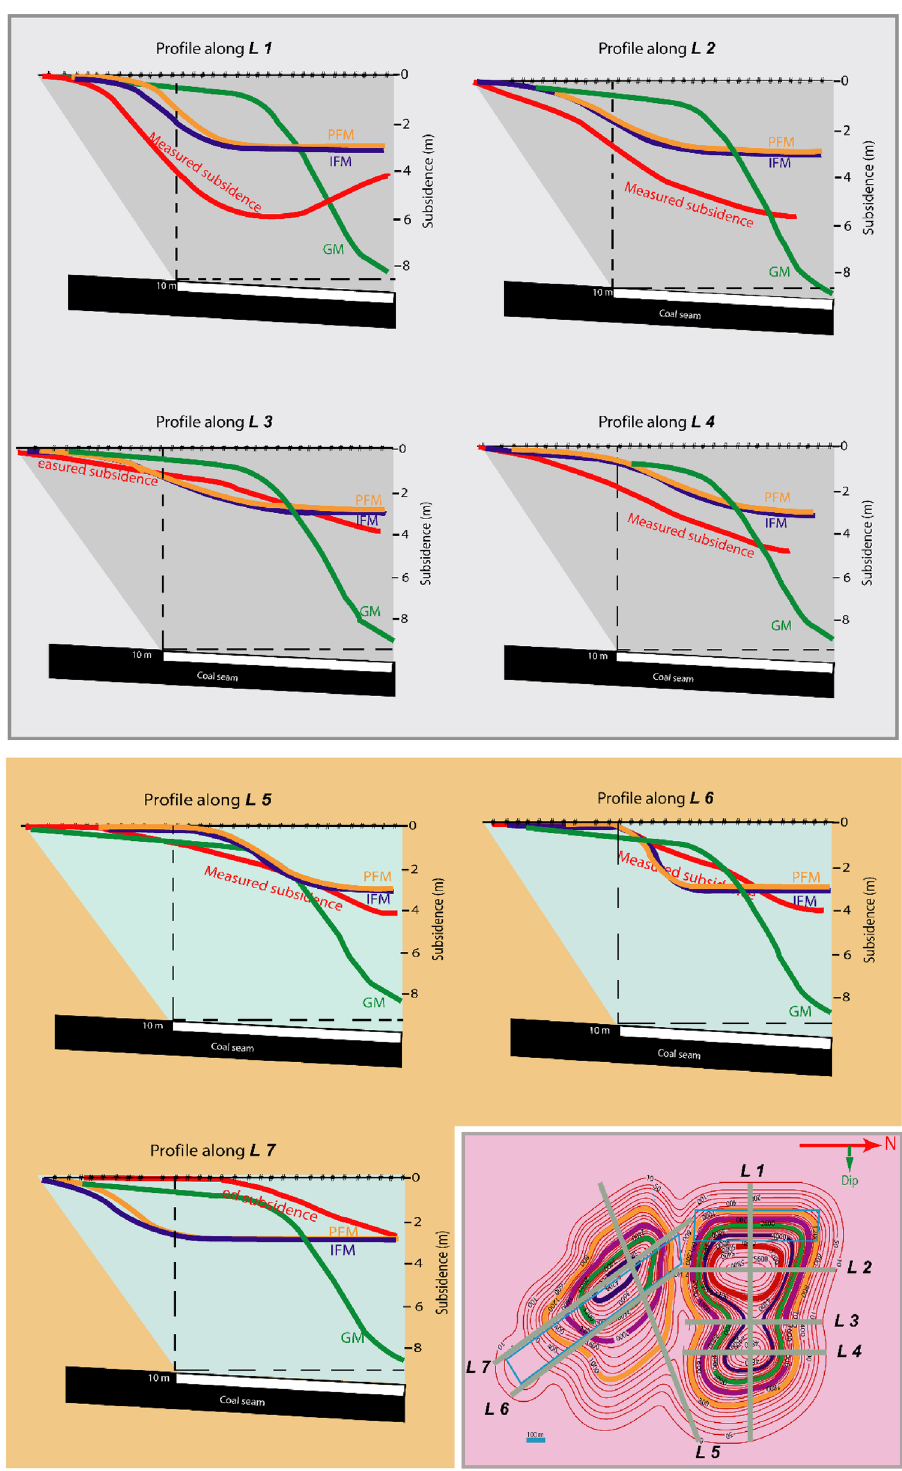
Figure 1. Predicted and measured subsidence profiles by empirical methods. GR_Graphical Method; PFM_ Profile Function Method; IFM_Influence Function Method. (Modified after Ahmed 9